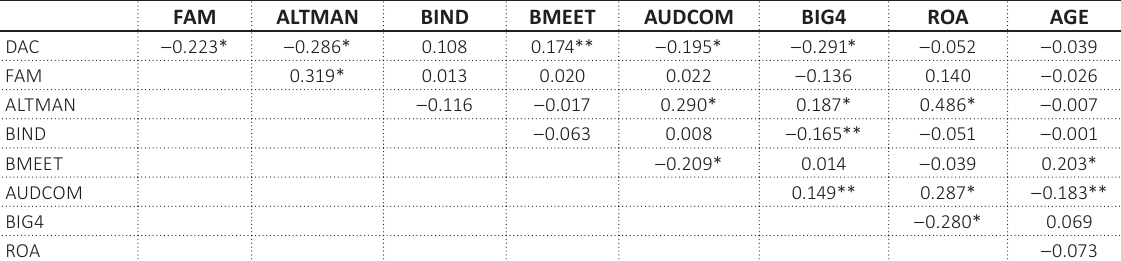
Table 3. Pearson correlation matrix